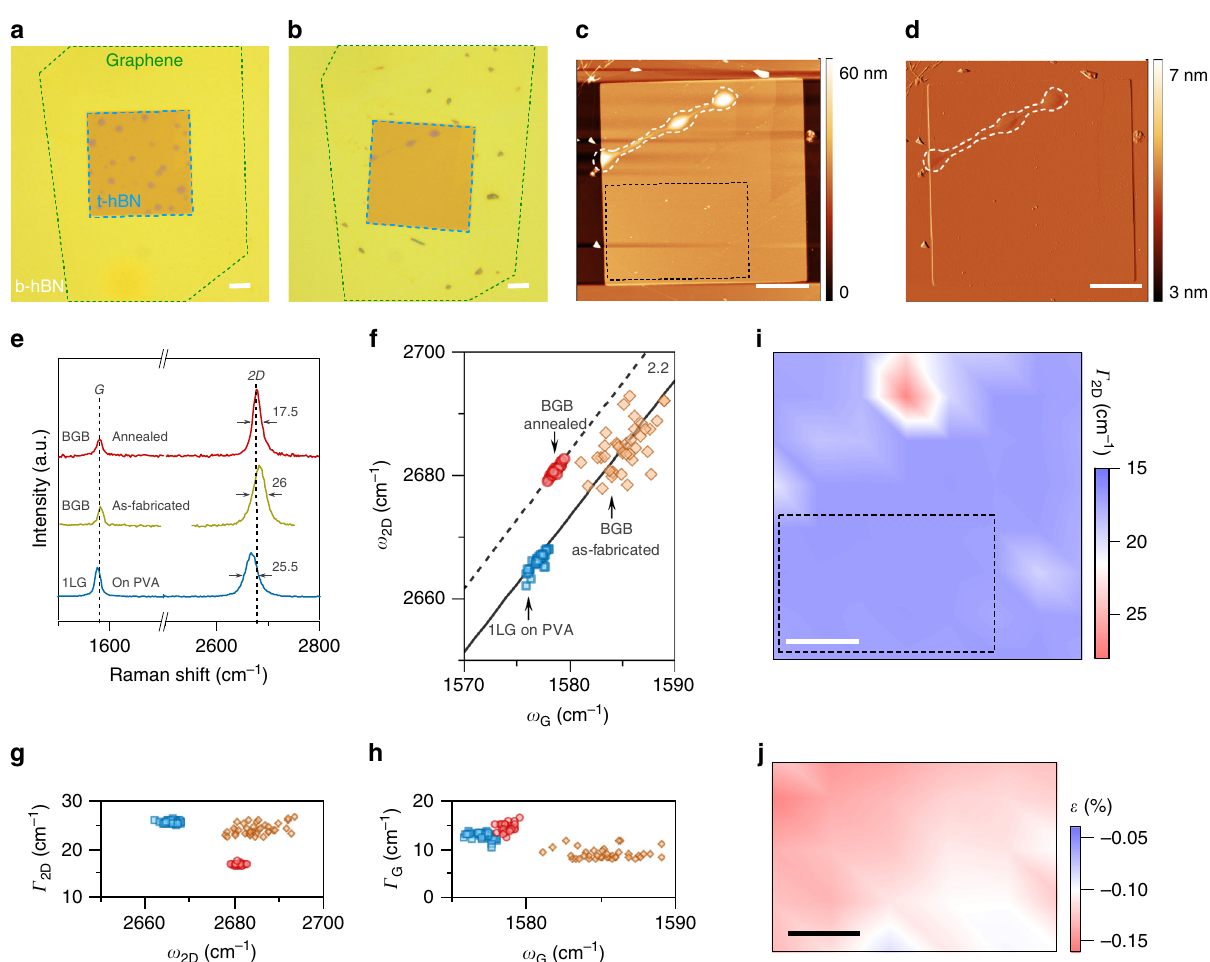
Fig. 3 Evaluation of graphene material quality. Optical images of a BGB stack a after lamination (i.e., as-fabricated) and b after UHV annealing, indicating the effectiveness of the annealing step in removing blisters. High-resolution c AFM topography and d AFM topography error images con fi rm the cleanliness of the annealed BGB stack. Notice the remaining blisters in the top left corner of the AFM images. The black dashed box represents the region, which we used for comparing the Raman data before and after UHV annealing. e Typical Raman spectra of monolayer graphene (1LG) obtained at the different stages of the BGB stack fabrication. The black dashed lines mark the position of G and 2D lines after UHV annealing. The numbers next to the 2D lines give the FWHM. f The plot of ω 2D against ω G . The dashed and solid black lines have a slope of 2.2. The scatter plots of ( g ) Γ 2D against ω 2D , and h Γ G against ω G . The symbols in these two plots correspond to the data in the f . i The spatial map of Γ 2D of the annealed BGB stack, con fi rming the ability of Raman to provide precise information about the location of blisters. The black dashed box in this plot is the same region as in the AFM image of the c . j The estimated strain amplitude in the marked rectangular region. All scale bars are 5